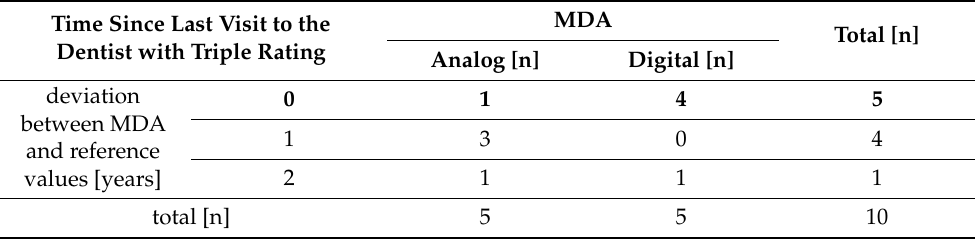
Table 3. Results for the “time since the last dental visit”—deviation between the MDA and reference values for the analog (n = 5) and digital (n = 5) MDA. The absence of deviation from the reference value is shown in bold type.